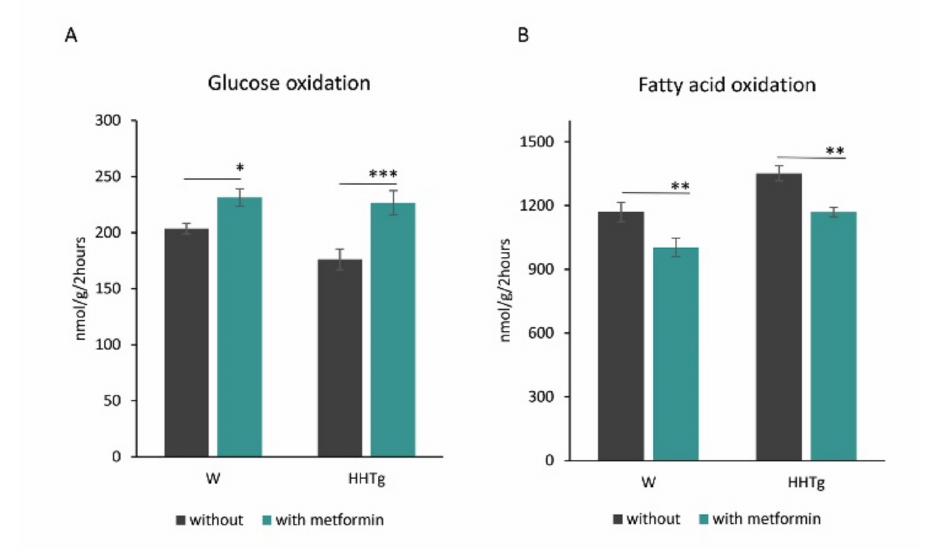
Figure 2. Effects of metformin on glucose ( A ) and palmitate oxidation ( B ) in the myocardium in Wistar control (W) and hereditary hypertriglyceridemic (HHTg) rats. Data are mean ± SEM; n = 8 for each group. Significance was determined using two-way ANOVA and Fisher’s LSD post-hoc test (* denotes p < 0.05; ** denotes p < 0.01; *** denotes p <